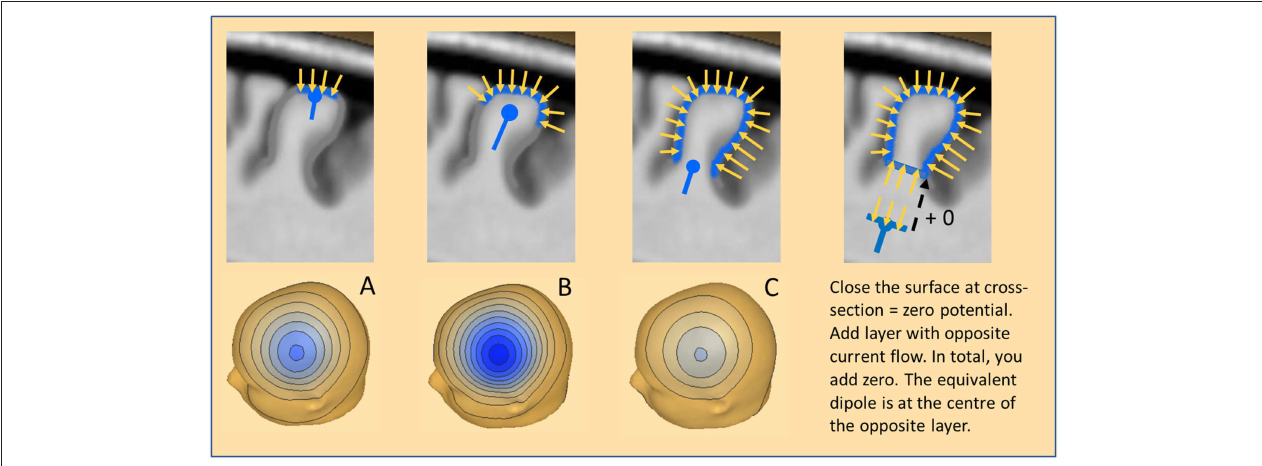
FIGURE 3 | The equivalent dipole. Three cases of cortical patches are illustrated with a resulting net inward current of radial orientation: (A) Small patch on the crown of a gyrus. (B) More extended patch spreading into the sulci. (C) Large patch involving both crown and deep sulci. The equivalent radial dipole sums the local currents along the cortical columns and is moving progressively deeper. For more details see text.